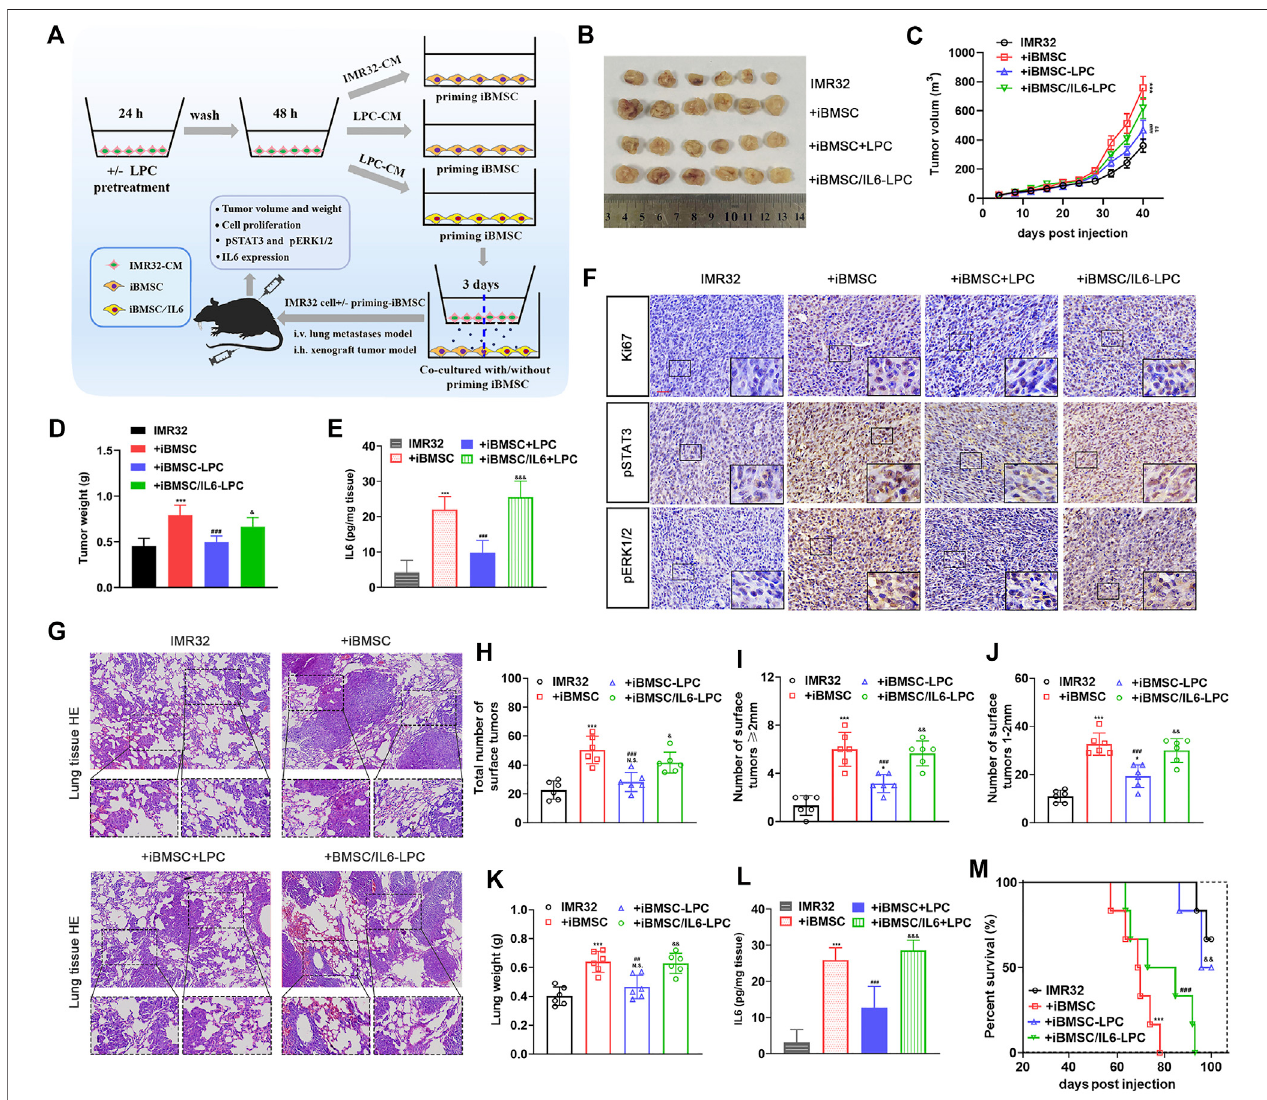
FIGURE 5 | LPC suppresses the carcinogenic effect of IMR32-priming iBMSC in vivo , which could be reversed by exogenous overexpression of IL6. (A) The schematic diagram shows the preparation procedure of cells to be transplanted and the construction process of subcutaneous xenograft tumor and lung metastasis model in nude mice. Brie fl y, IMR32 was injected into the fl anks of nude mice alone or mixed with IMR32-derived CM-priming iBMSC, LPC-CM-priming iBMSC or LPC- CM-priming IL6-expressing iBMSC (iBMSC/IL6), respectively. Meanwhile, the cells prepared in the same manner were intravenously injected into nude mice to establish the lung metastasis model. During modeling, another intravenous injection of iBMSC were performed at the second month of vaccination. (B) Representative imagesoftumor obtainedfrom miceat 40 days aftersubcutaneous injection. (C) Tumorgrowth curve. (D) Tumorweight. (E) Theexpression level ofIL6intumor tissues was determined by ELISA. (F) Representative images of IHC staining of Ki67, pSTAT3 and pERK1/2 in tumor tissues. (G) Representative HE staining images obtained from mouse lungs 2 months after tail vein injection. (H – J) The number of tumors on the lung surface. (K) Lung weight. (L) IL6 expression in lung metastatic lesions. (M) Survival curve of mice. ( *p < 0.05, **p < 0.01 and ***p < 0.001 vs. IMR32; #p < 0.01, ##p < 0.01 and ###p < 0.001 vs. + iBMSC; & p < 0.05, && p < 0.01 and &&& p < 0.0001 vs. + iBMSC +